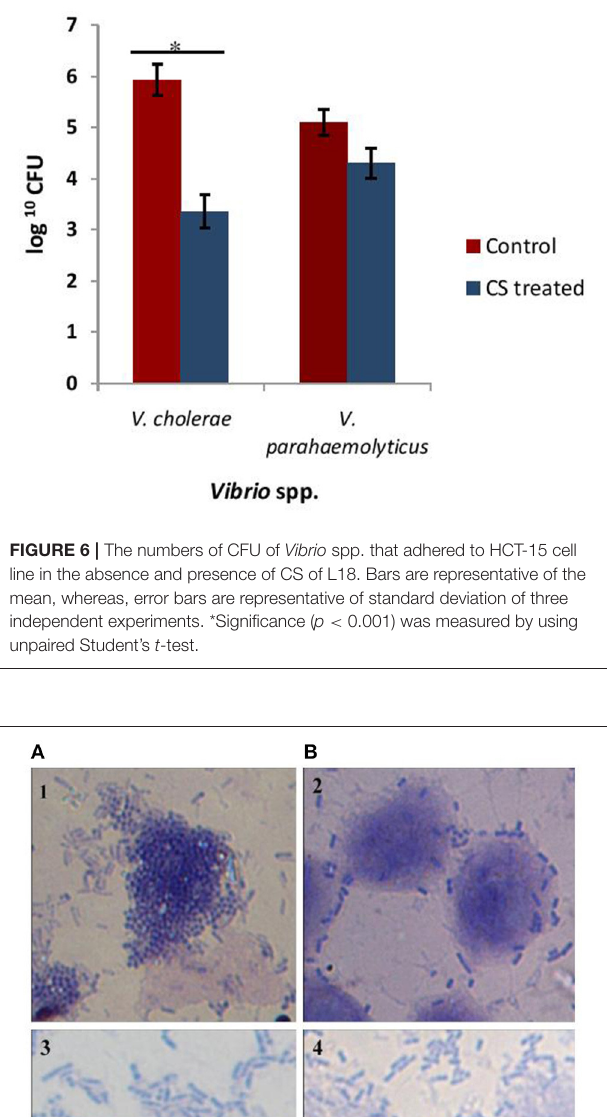
TABLE 3 | Percentage of lactic acid produced by lactobacilli isolates.